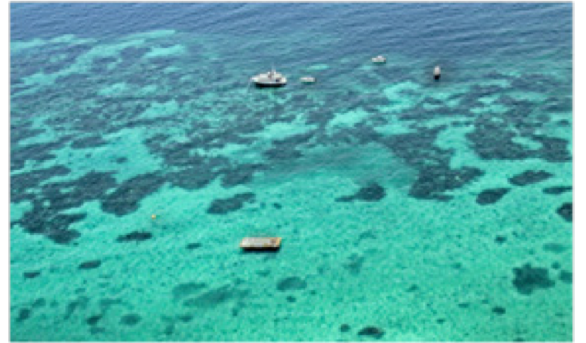
Figure 5. Aerial view of Cheeca Rocks reef, barge serving as